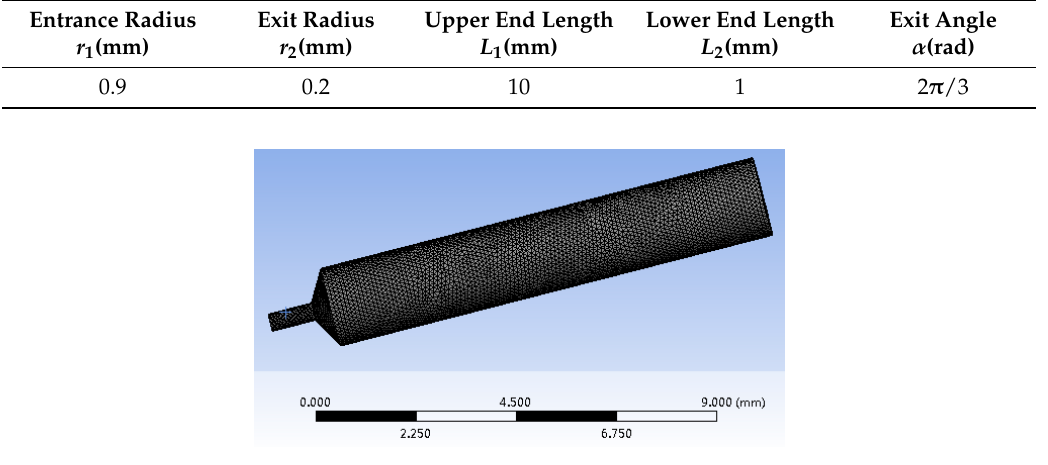
Figure 3. The meshed internal flow passage.